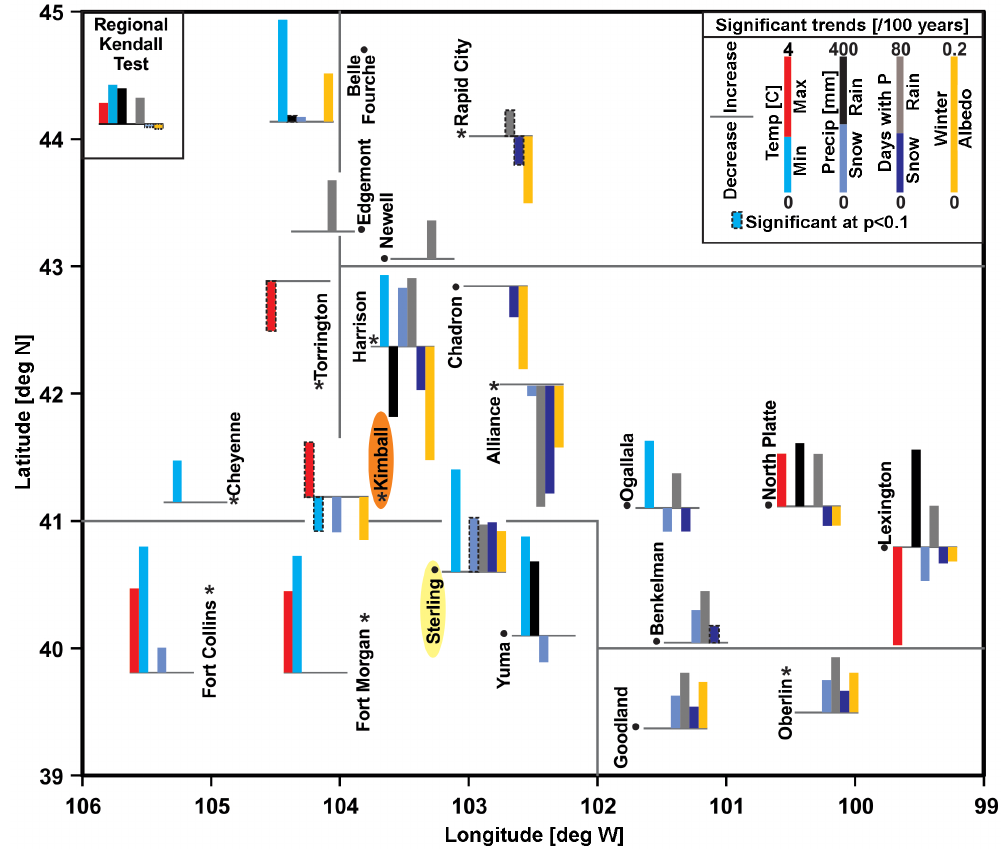
Figure 3. The spatial distribution of the climatic trends at the p < 0.05 level for the period from 1951 to 2010, shown per century. Trends shown with a dashed border are at the p < 0.10 level. Significant RKT trends are shown in the top left. Sterling and Kimball stations are